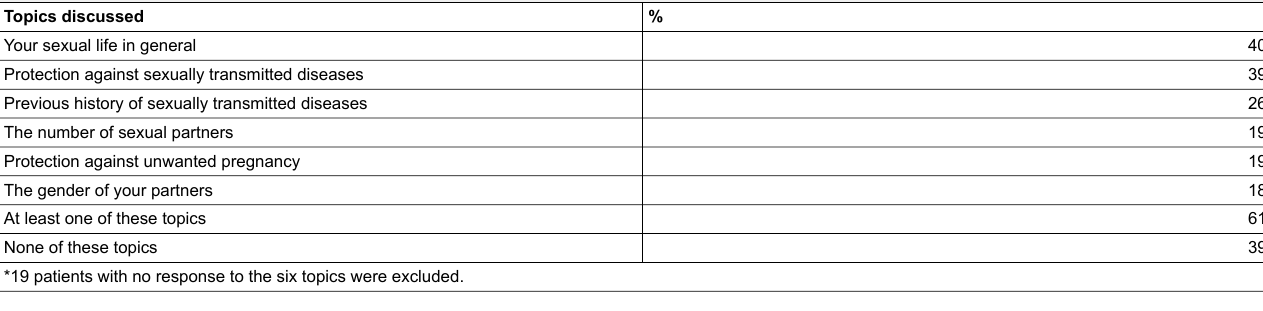
Table 1: Proportion of patients ever having discussed sexual issues with a physician (n = 1433*). Topics discussed